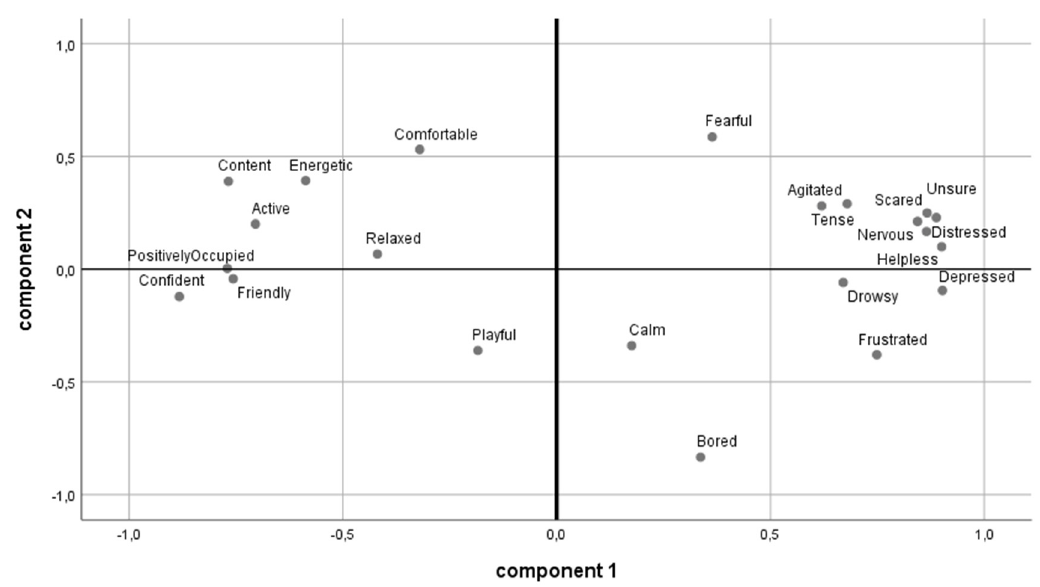
Figure 4. View of the principal component analysis and the loading of each term in components 1 and 2.